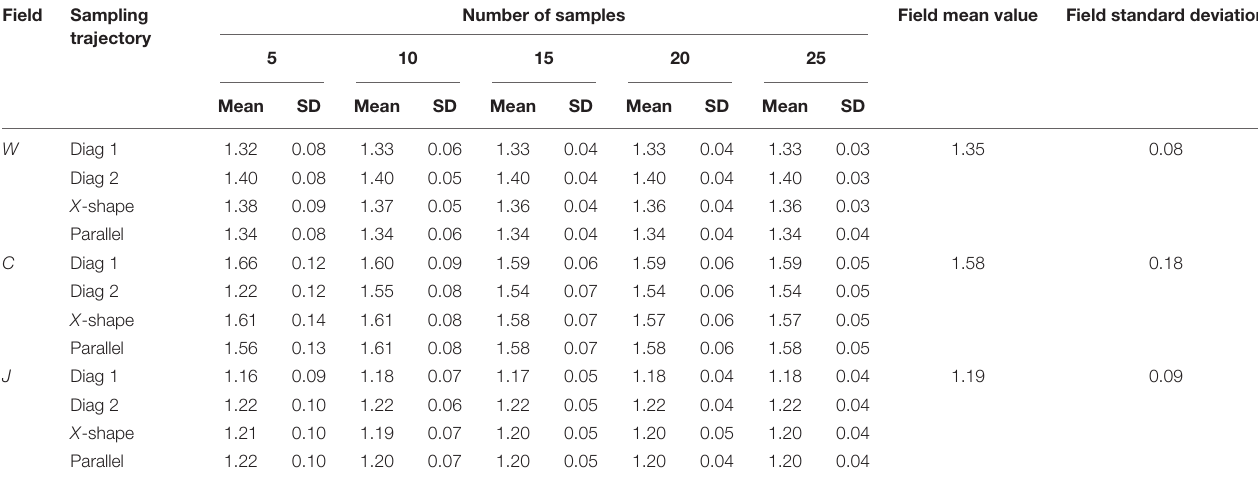
TABLE 1 | Mean value of soil organic carbon (SOC) content (% SOC g g − 1 ) in the simulated composite samples, and standard deviation (SD), for the different simulated sampling trajectories and number of samples to form the composite. Field Sampling trajectory